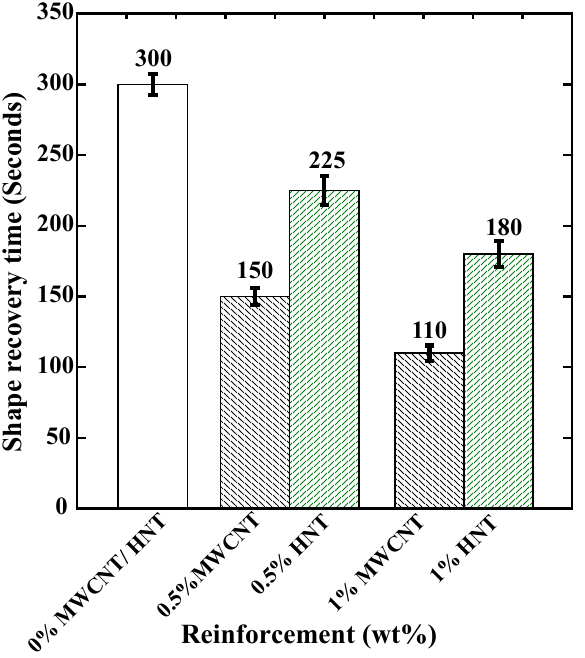
Figure 8. Time required (in seconds) for 100% of shape recovery for 4D-printed pure SMPU and SMPU reinforced with 0.5 and 1 wt% of MWCNTs and